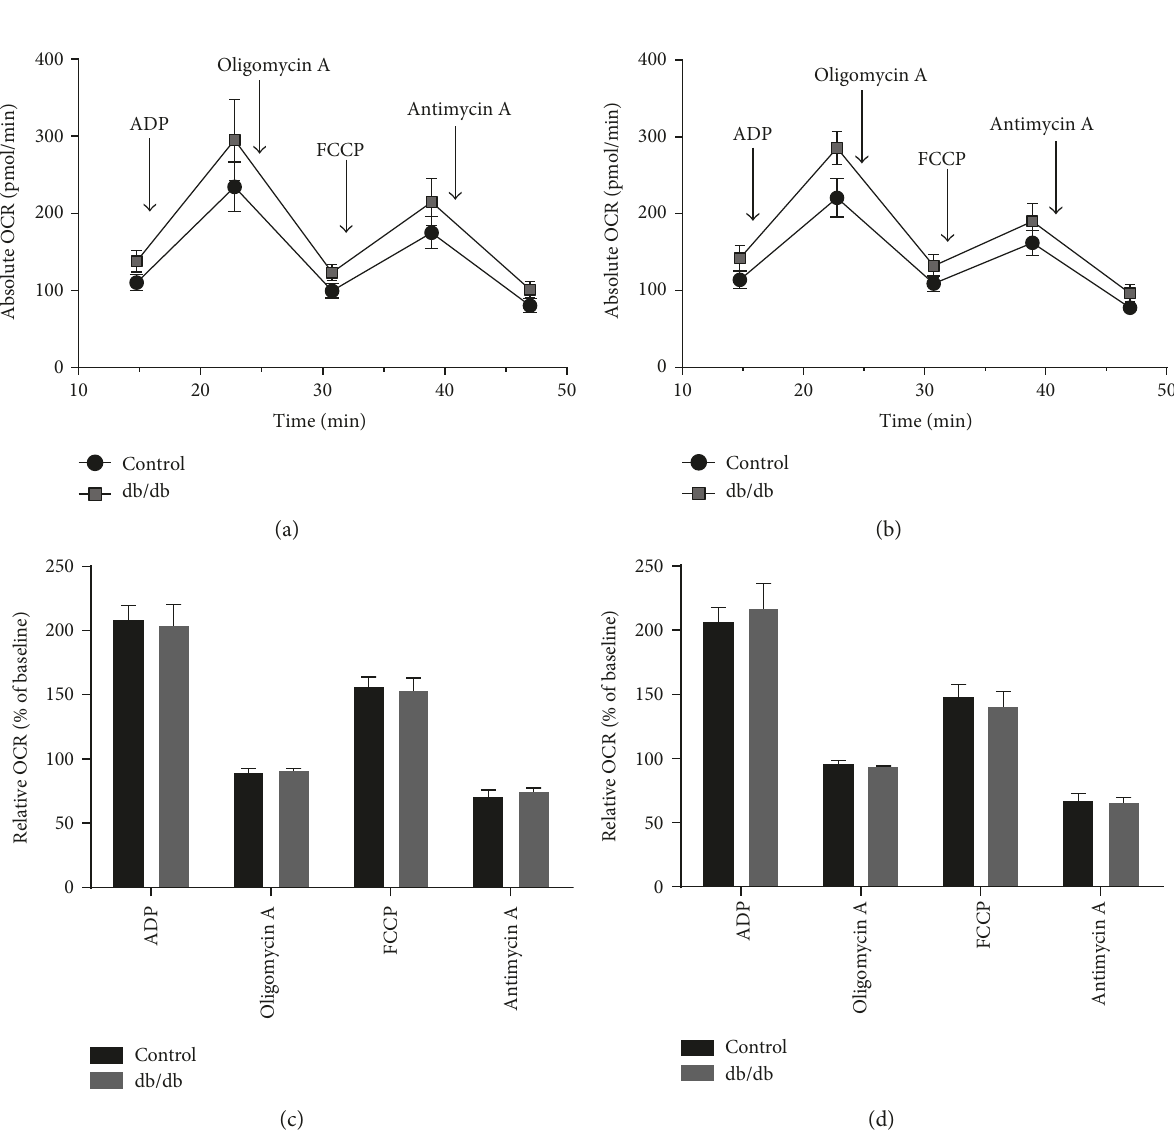
Figure 2: Mitochondrial oxygen consumption rates (OCRs) of isolated brain mitochondria from control and db/db mice. Absolute (a and b) and relative (c and d) oxygen consumption rates of the brain mitochondria from control and db/db mice, with glutamate (a and c) and glutamine (b and d), both in the presence of malate, as substrates. Arrows (in a and b) indicate the speci fi c time points of compound addition. ADP stimulates coupled respiration, oligomycin A inhibits the ATP synthase, FCCP induces uncoupled respiration, and antimycin A inhibits complex III of the electron transport chain. Baseline is not shown. Results are presented as means ± SEM, n = 4 – 7 , Student ’ s t -test, p < 0 05